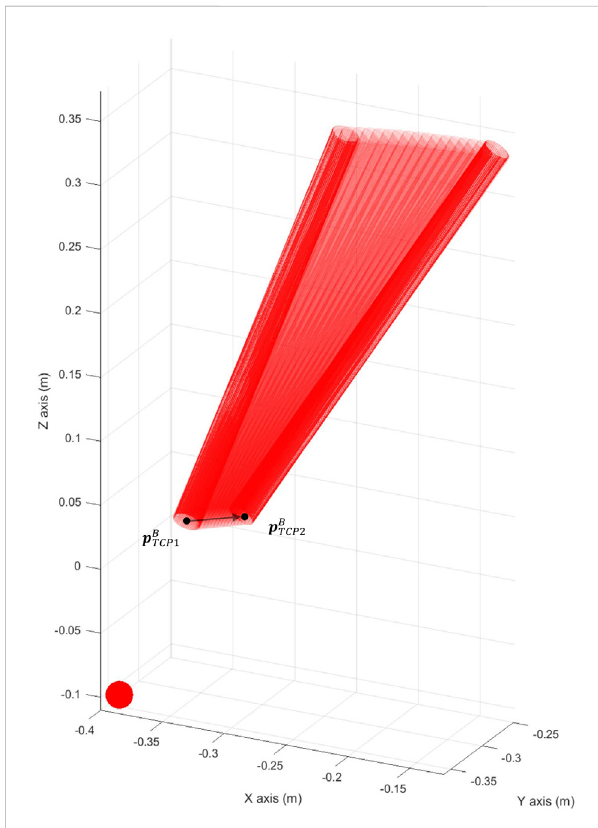
FIGURE 14 Camerakeepingtrackofthetarget point p B r while thepelvitrainer is in